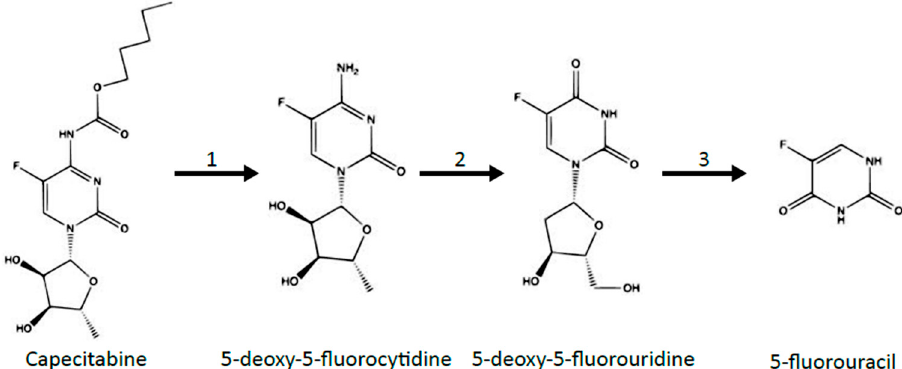
Figure 1. The three-step metabolism of capecitabine, another commonly used antineoplastic drug converted to 5-fluorouracil. 1—carboxylesterase; 2—cytidine deaminase; 3—thymidine phosphorylase. Reactions occur in the following sites: 1—liver; 2—liver and tumor; 3—tumor. Based on: -Mar- tino et al. with modification.